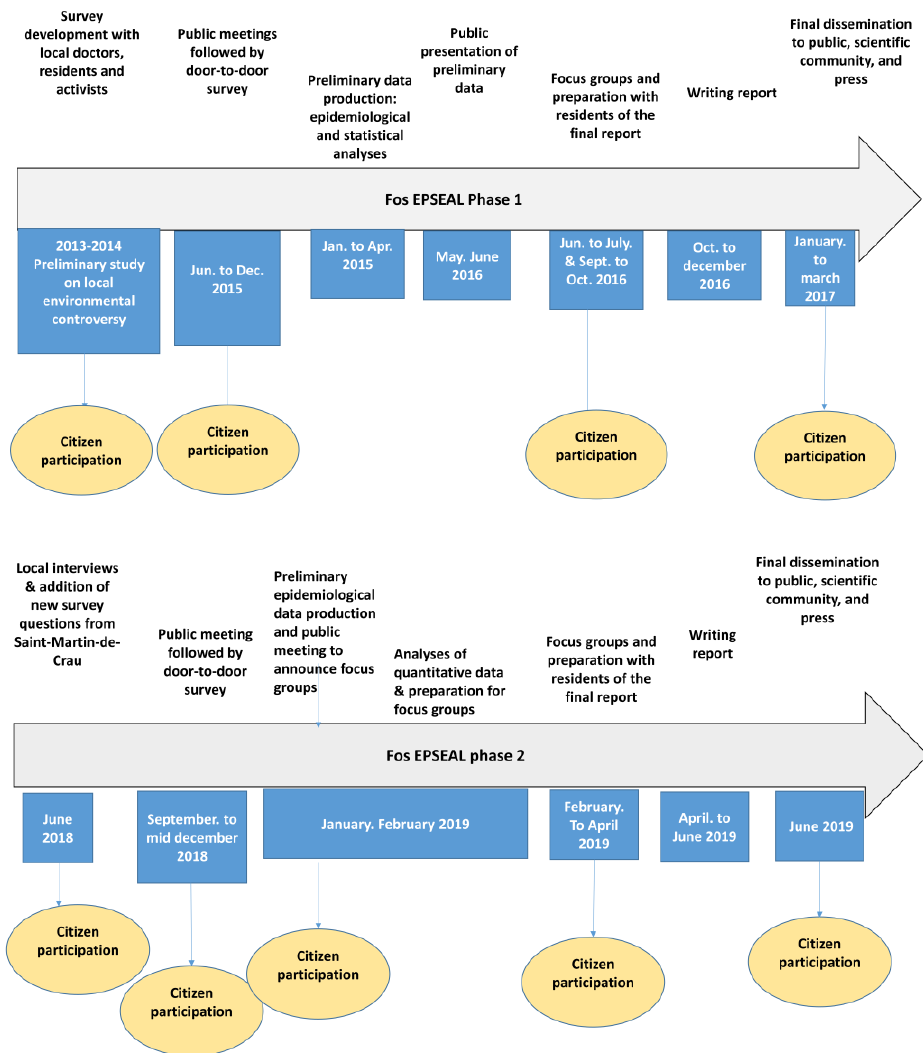
Figure 1. Study timeline and participatory elements of the process.